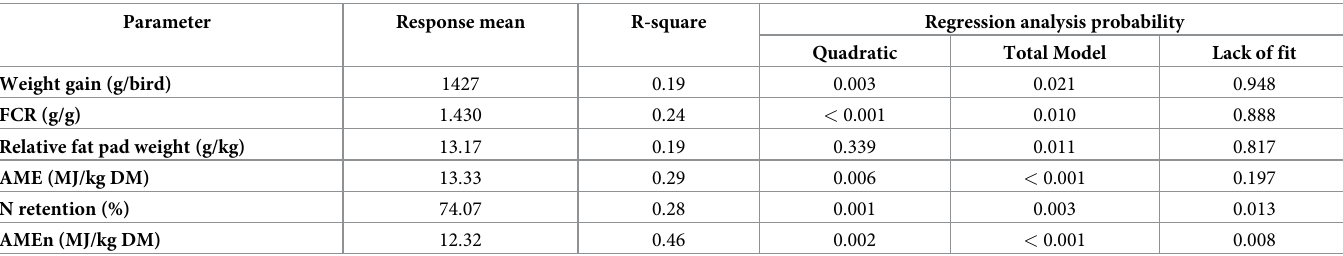
Table 8. Polynomial fitted model (P < 0.05) for growth performance from 7 to 28 days post-hatch and nutrient utilisation from 24 to 27 days post-hatch. Parameter Response mean R-square Regression analysis probability Quadratic Total Model Lack of fit Weight gain (g/bird)